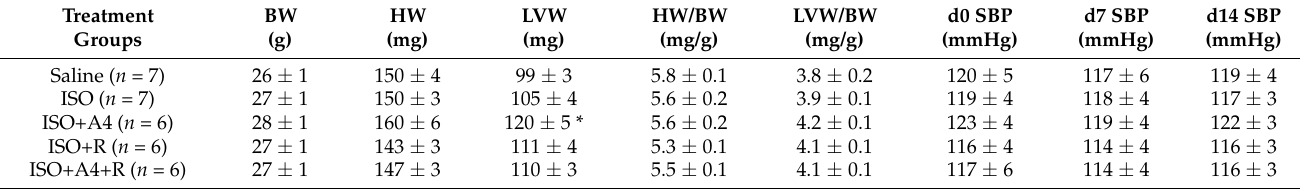
Table 1. The effects of ISO as well as RLX and/or A4 treatment on systolic blood pressure (SBP), animal body weight (BW), heart and LV weight 14 days post-injury.